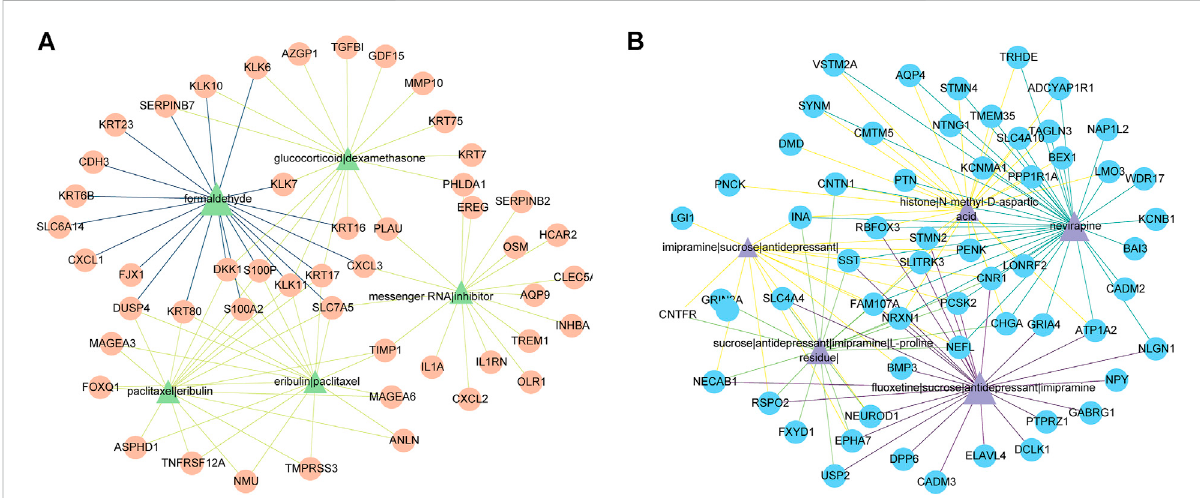
FIGURE 7 The predicted top fi ve drugs and their gene networks. The color and thickness of the edges are inversely proportional to the p -value of drugs and DEGs. (A) Five drugs (green triangles) and 50 upregulated DEGs (orange circles). (B) Five drugs (purple triangles) and 59 downregulated DEGs (blue circles).